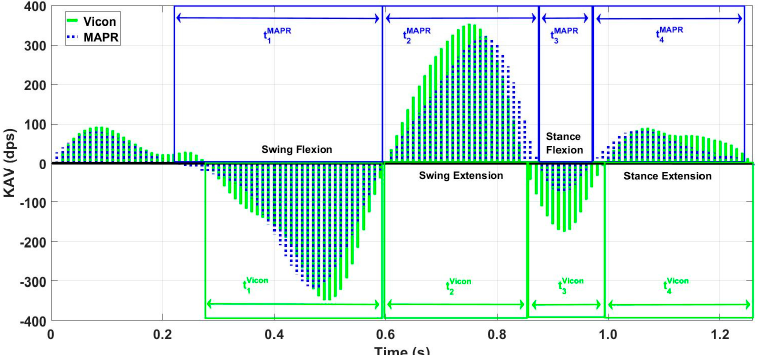
Figure 6. Time interval comparison of manually aligned Vicon and MAPR KAV Signals. While areas and signal profiles are similar, they differ in length of flexion and extension intervals. Boxes delimit the flexion and extension intervals of swing and stance determined by each KAV. Difference in length of time interval was used in Bland–Altman analysis. Blue, MAPR KAV signal; Green, Vicon KAV